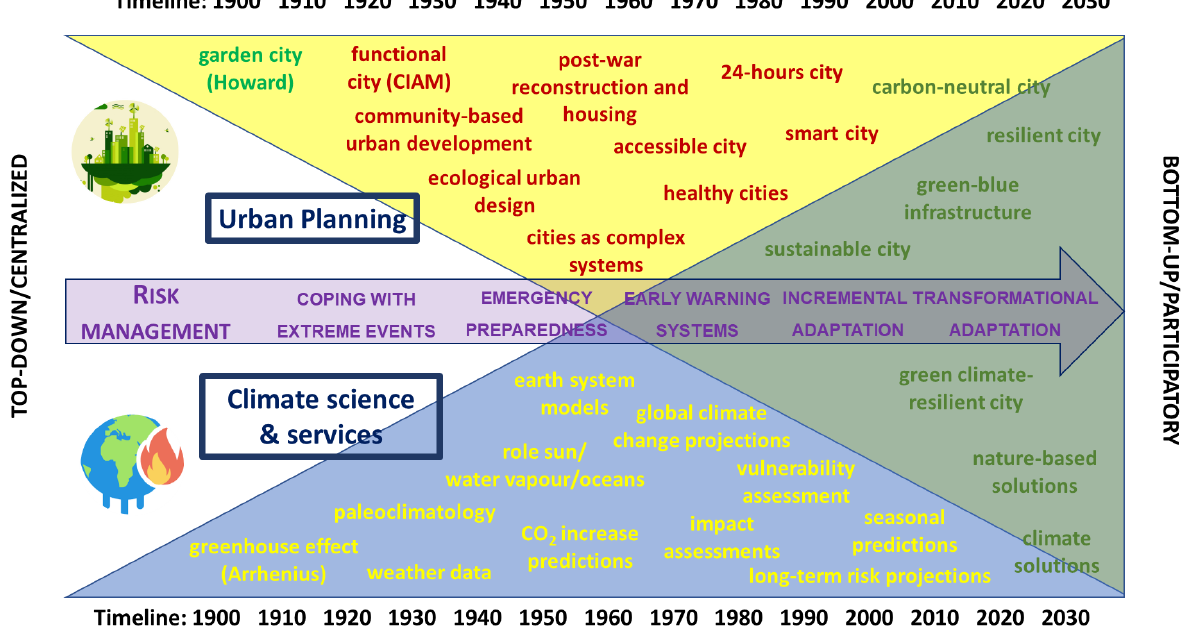
Figure 1. Integrating urban planning concepts, climate science, and action over